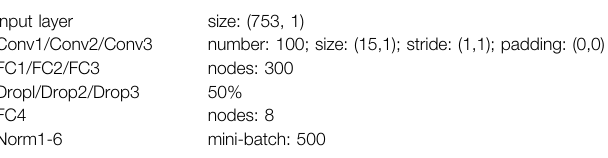
TABLE 5 | Con fi guration of the convolutional neural